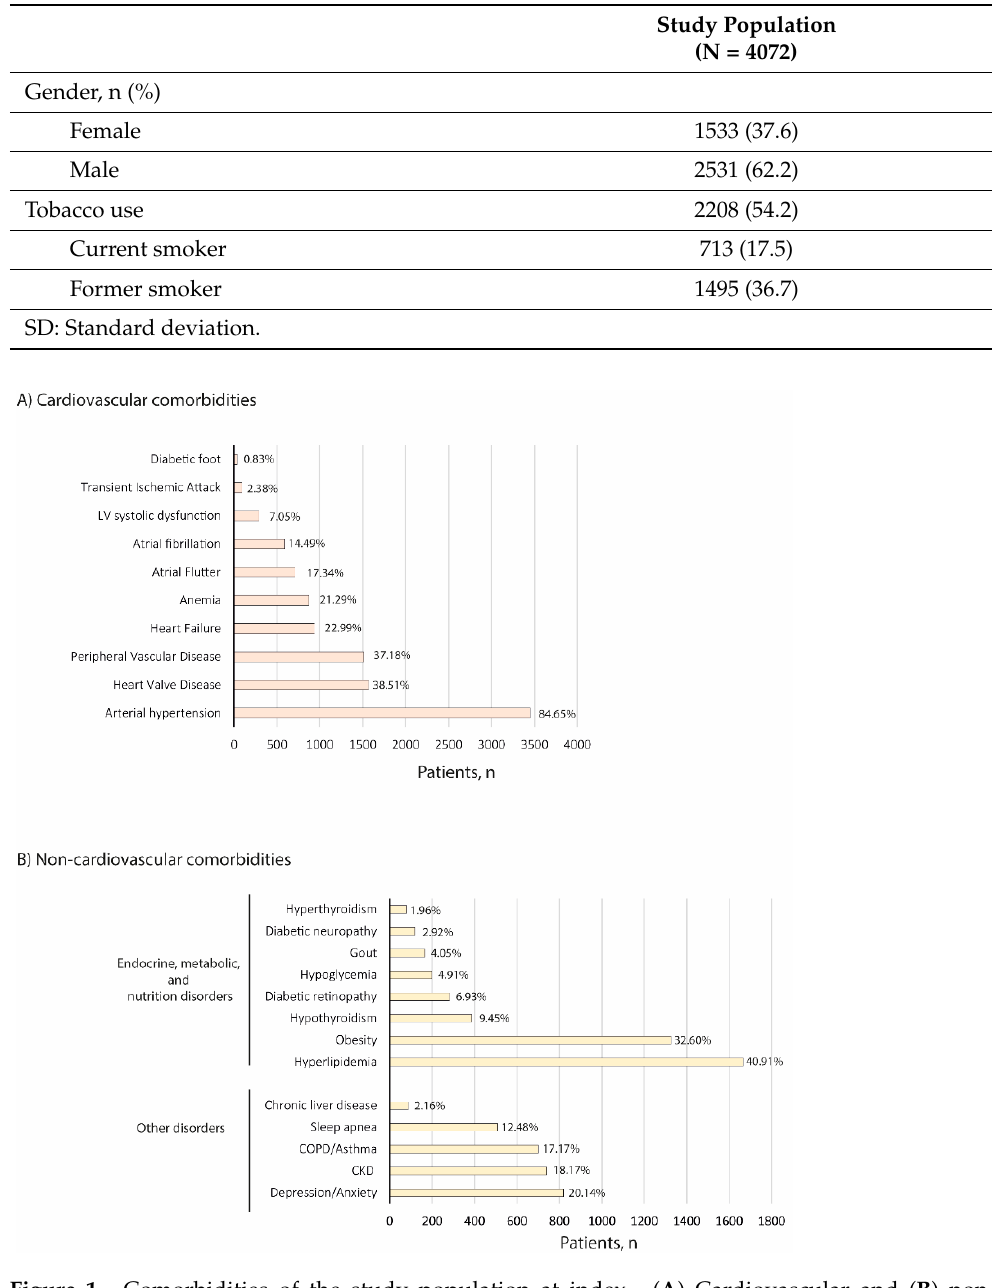
Table 1. Sociodemographic of the study population at index Table 1. Cont.